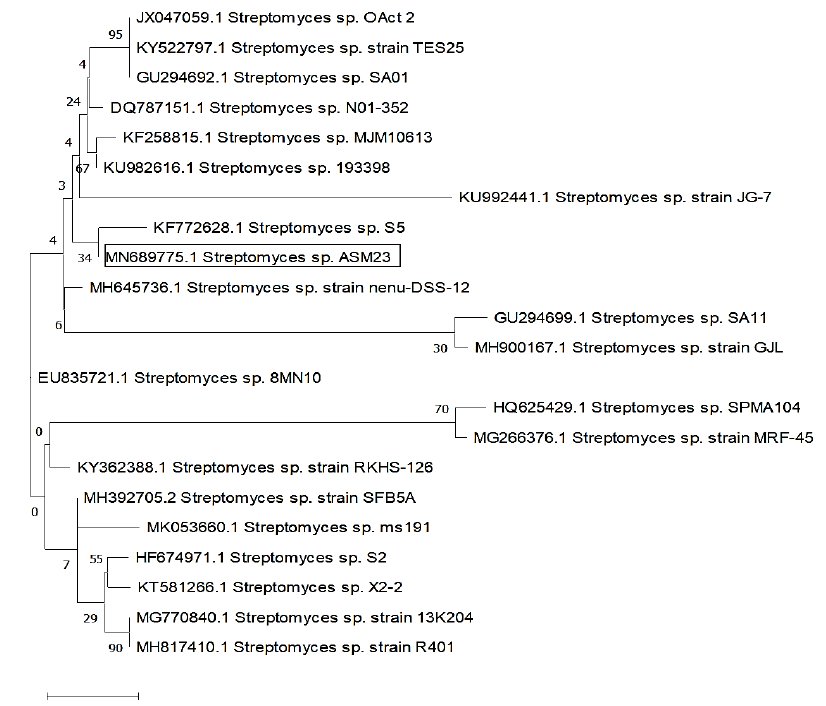
Figure 2. Evolutionary relationships of taxa related to Streptomyces sp. ASM23 is based on a 16S rDNA sequence using the maximum likelihood method. rDNA sequence using the maximum likelihood